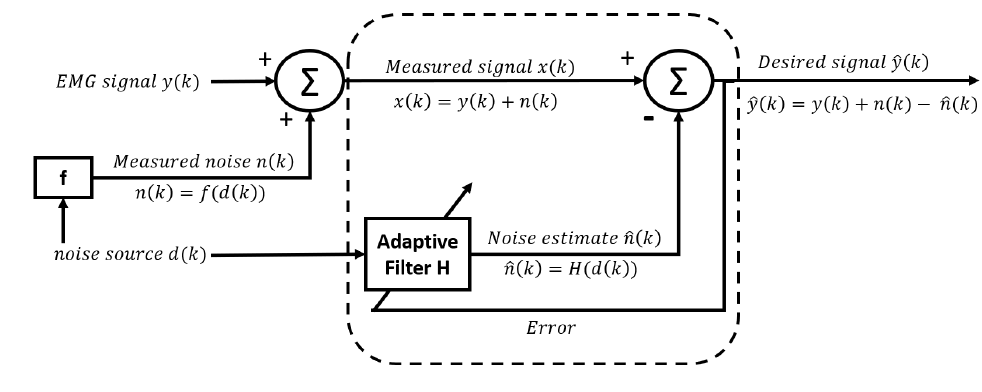
Figure 6. Block diagram of the adaptive noise canceller along with the measured signal composition.